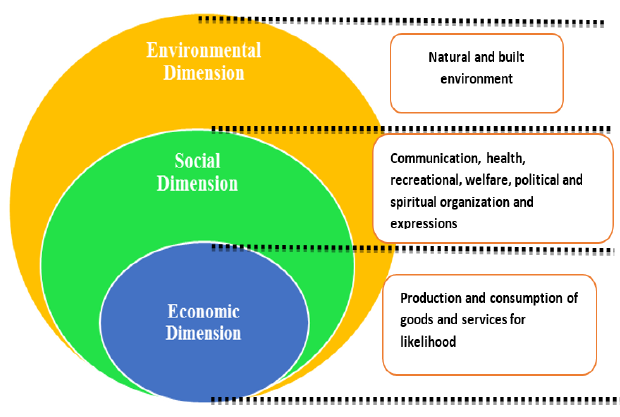
Figure 1. Dimensions of Neighbourhood formation and transformations. Adapted: Pillai, (2013) Rural morphology dwelt with the various forms of